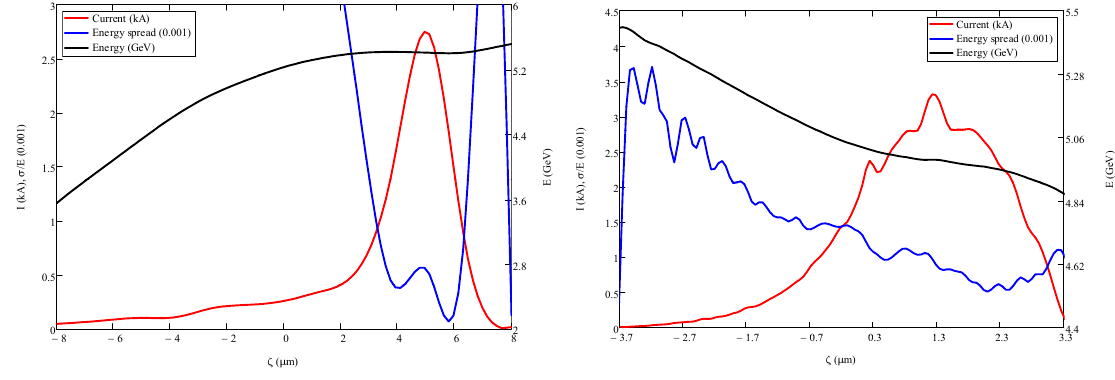
Figure 2. Energy, current and energy spread slice profiles as a function of the intrabunch ζ coordinate, for the beam distributions Rossi–5 ( left ) and Maynard–5 ( right ) at the undulator entrance.